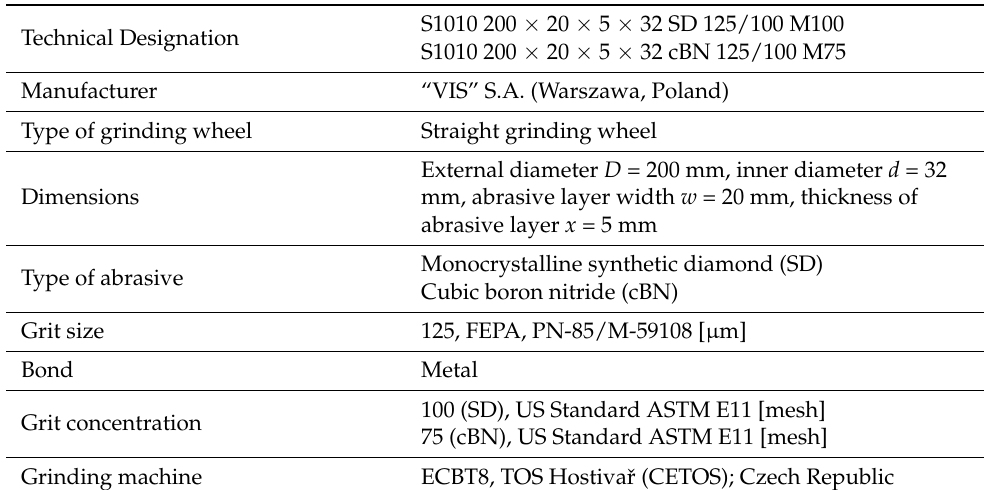
Figure 1. Test stand: 1—electro-spark discharge generator, 2—electric voltage supply to the working electrode, 3—dielectric liquid nozzle, 4—grinding wheel, 5—working electrode, 6—card terminal, 7—PC computer, 8—ECBT8 grinder. Table 1. Characteristics of grinding wheels and machine tools used for the tests.